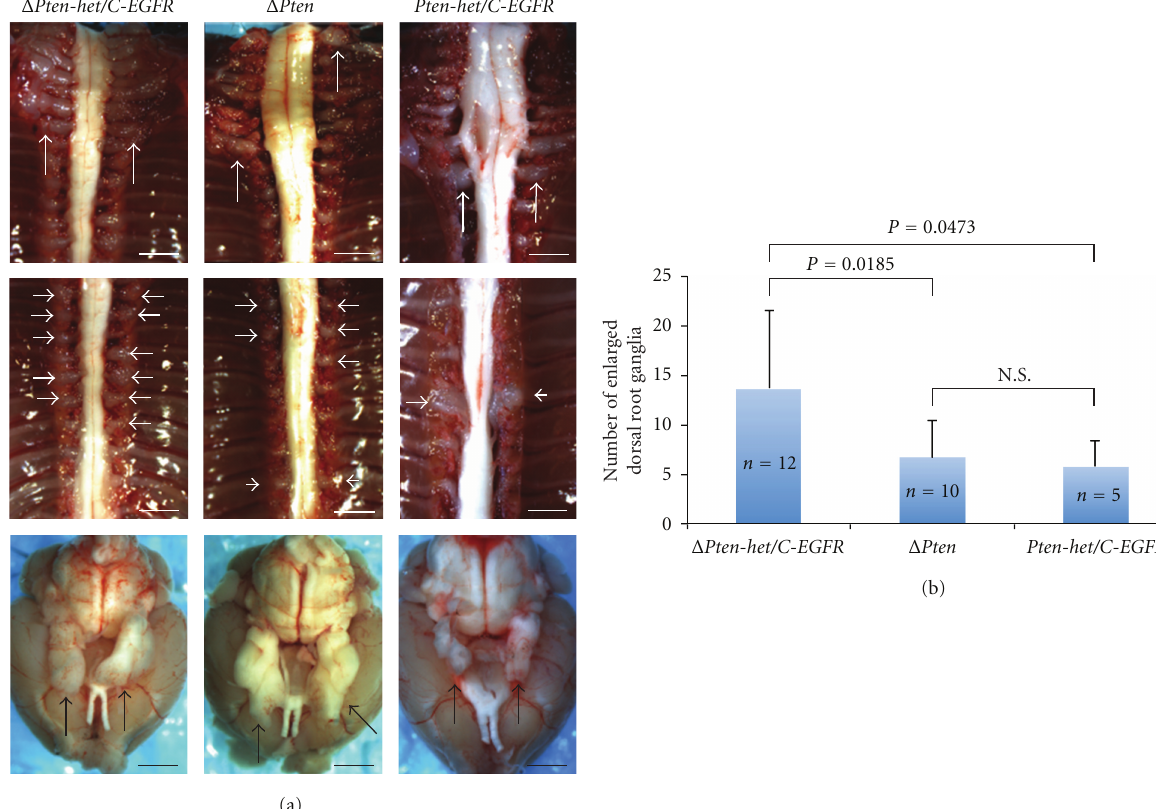
Figure 2: Pten dosage with EGFR overexpression a ff ected enlarged dorsal root ganglia tumor multiplicity. (a) Left: representative of an early-onset peripheral nervous system phenotype observed in a 38-day Dhh -Cre; Pten flox/flox ; Cnp - EGFR ( Δ Pten / C - EGFR ) experimental mouse. Brachial plexus: majority of the dorsal root ganglia and trigeminal nerves were enlarged. Middle: representative of a late-onset peripheral nervous system phenotype observed in a 104-day Dhh -Cre; Pten flox/flox ( Δ Pten ) control mouse. Brachial plexus: several dorsal root ganglia and trigeminal nerves were enlarged. Right: representative of a late-onset peripheral nervous system phenotype observed in a 274-day Dhh -Cre; Pten flox/ + ; Cnp - EGFR ( Pten-het / C - EGFR ) control mouse. Brachial plexus: several dorsal root ganglia and trigeminal nerves were enlarged. Top panels: brachial plexi; middle panels: dorsal root ganglia; bottom panels: brain with trigeminal nerves; arrows indicate peripheral nervous system phenotype; scale bars, 2 mm. (b) Statistically significant di ff erences in the number of enlarged dorsal root ganglia isolated from Δ Pten / C - EGFR experimental cohort compared with control cohorts ( Δ Pten and Pten-het / C - EGFR ). Mean ± standard deviation; P : unpaired t -test; n : number of mice evaluated in each cohort; N.S.: